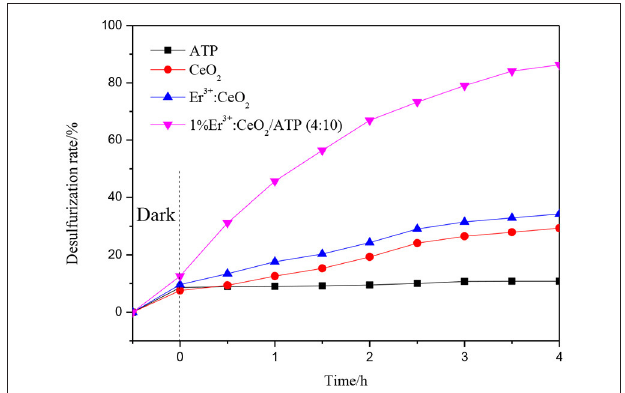
FIGURE 8 | Photocatalytic oxidation desulfurization efficiency with various catalysts.